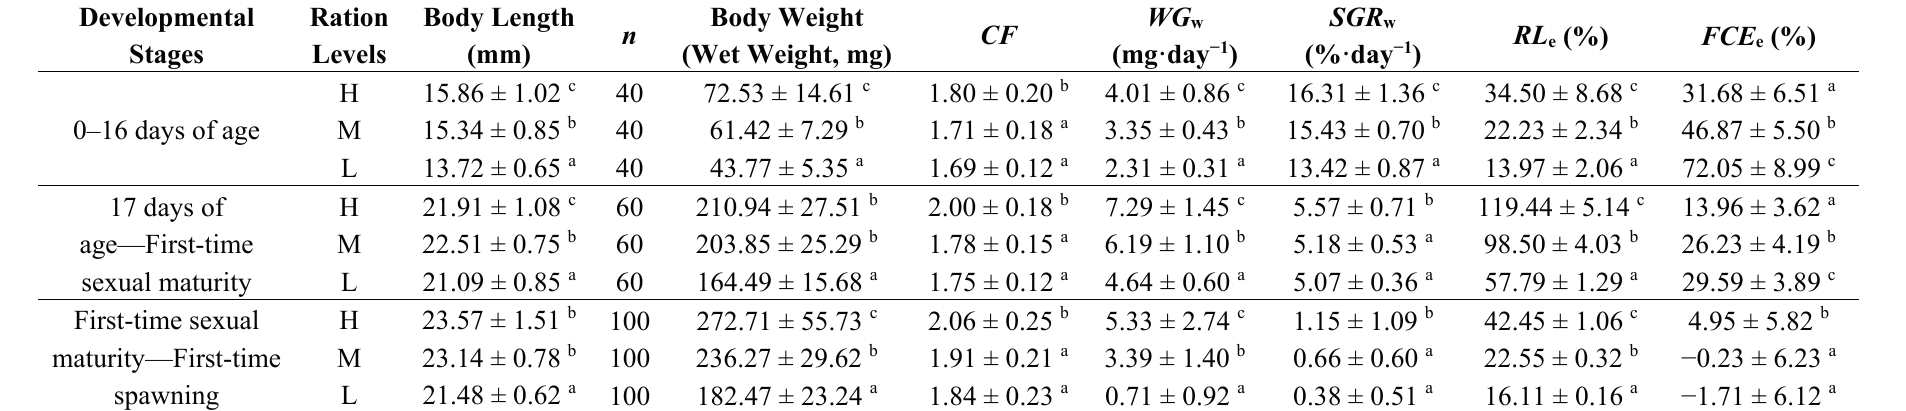
Table 1. The growth performances and FCE e of fish in three ration levels from birth to first-time spawning.